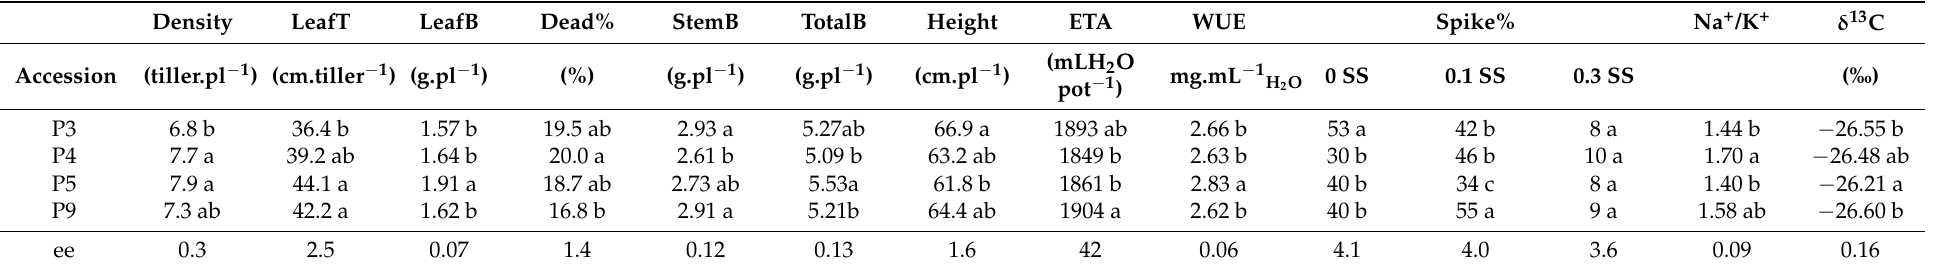
Table 1. Tiller density, leaf length per tiller (LeafT), green leaf biomass (LeafB), green stem biomass (StemB), total biomass dry weight (TotalB), percentage of dead biomass (Dead%), plant height (Height), accumulated evapotranspiration (ETA), water-use efficiency (WUE), proportion of spiked tillers (Spike%), Na + /K + ratio (Na + /K + ), and stable isotopes of C ( δ 13 C) of four tall wheatgrass accessions (P3, P4, P5, P9); Spike% values are given for the four accessions at each salinity